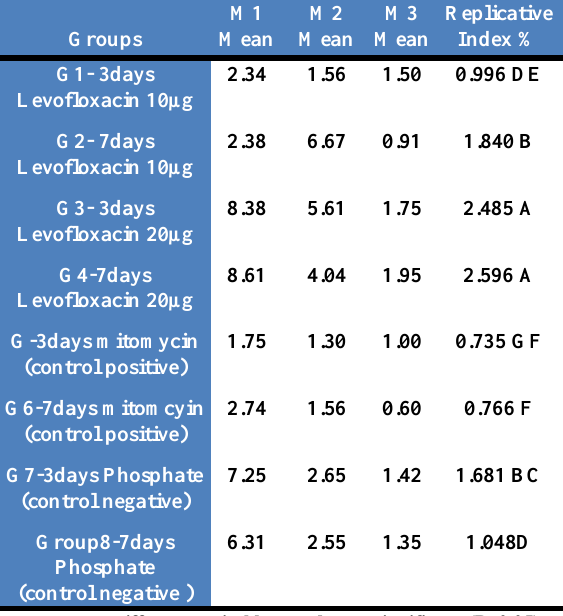
Table, 2: Replicative index of chick's embryo in two different stages (3 and 7 days of incubation) exposed to two different concentrations of levofloxacin.